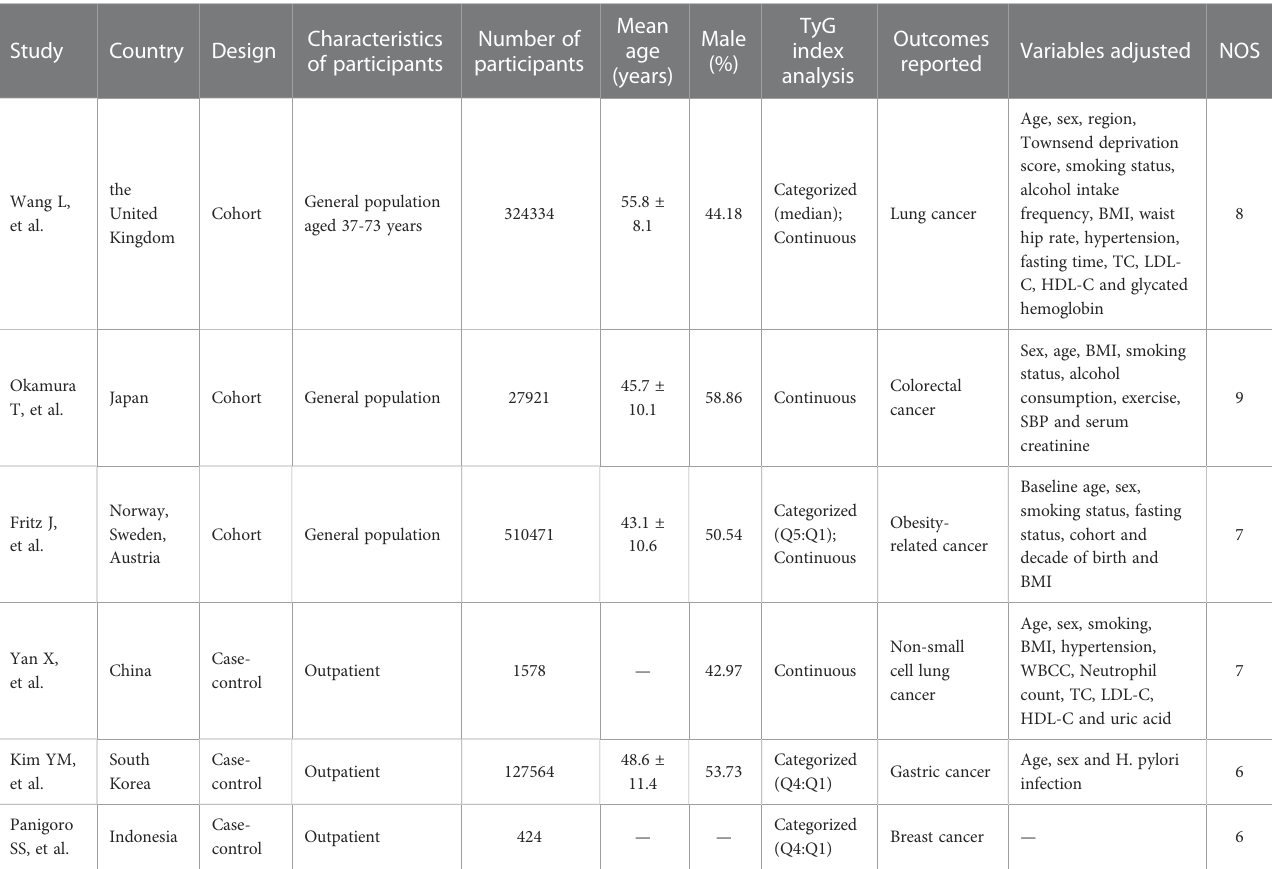
TABLE 1 Baseline characteristics of the participants.